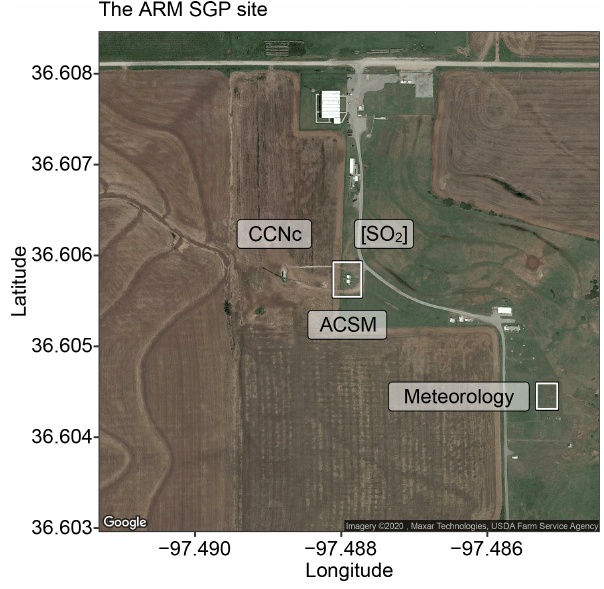
Figure 1. The ARM SGP site in Lamont, Oklahoma, USA, with marked locations of the instruments. Legend: meteorology – tem- perature and relative humidity measurements from the ARM Sur- face Meteorology Systems (MET) (Holdridge and Kyrouac, 1993; Chen and Xie, 1994); ACSM – Aerodyne Aerosol Chemical Spe- ciation Monitor (Ng et al., 2011); [SO 2 ] – concentrations of SO 2 measured by the ARM Aerosol Observing System (AOS; Hageman et al., 1996); CCNc – cloud condensation nuclei particle counter (CCNc) (Shi and Flynn, 2007; Smith et al., 2011a,b; Hageman et al., 2017). This image is adapted from satellite imagery © 2020 Maxar Technologies, USDA Farm Service Agency obtained through the Google Maps Static